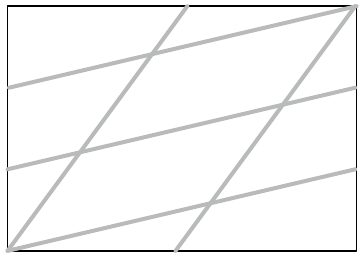
Figure 1 . Two stacks of branes, wrapping the four cycles D I , I = 1 , 2 differently, are intersecting. The inverse of the length of the fundamental domain segment is proportional to Q ξ and gives the effective decay